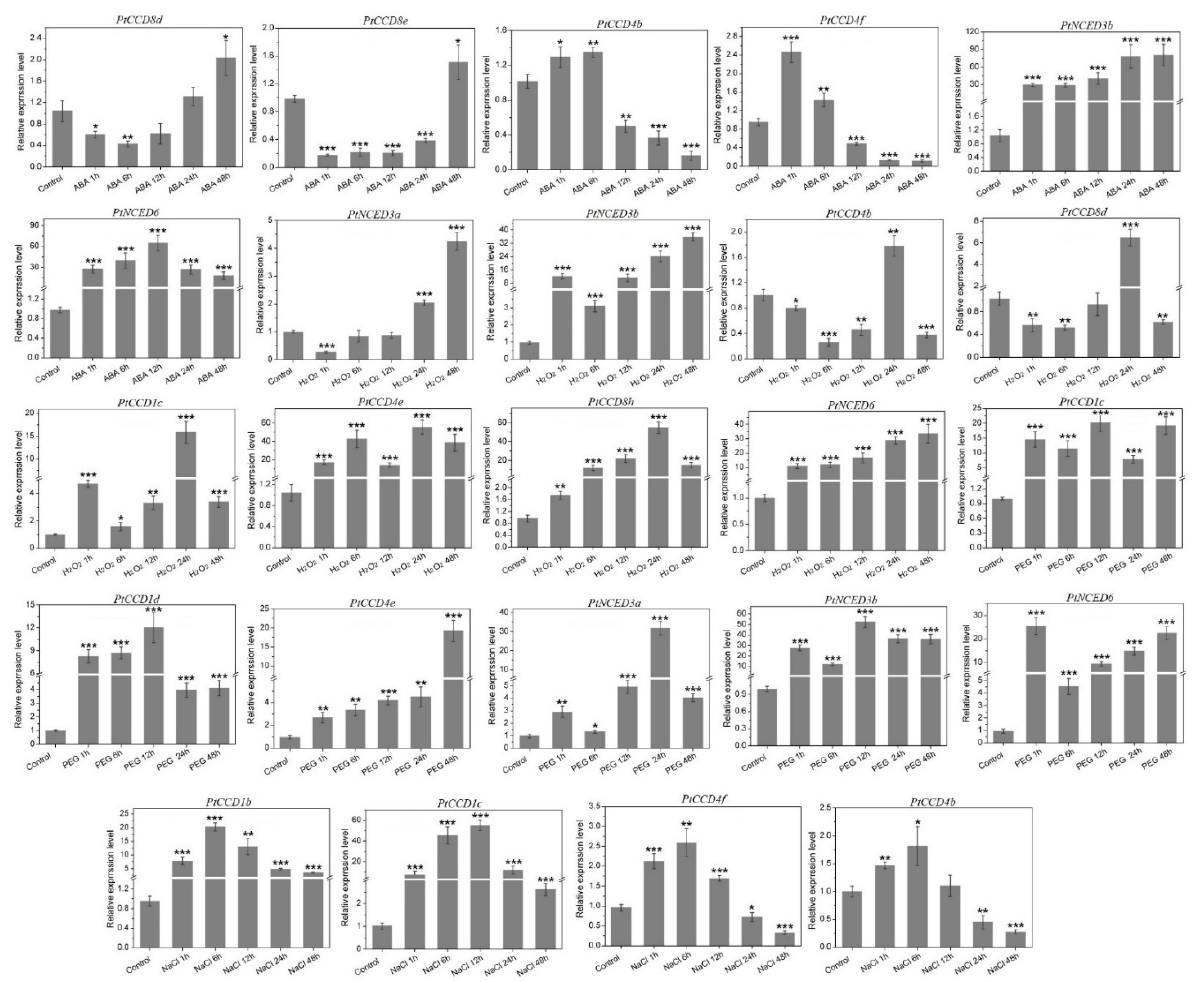
Figure 8. The qRT-PCR analysis of the PtCCD expression levels induced by abiotic treatments including ABA, H 2 O 2 , PEG 6000 , and NaCl. The vertical bars are representative of SD. Asterisk represents significant difference ( t -test, * p < 0.05, ** p < 0.01, and *** p < 0.001). Three independent experiments were performed. The data are normalized to poplar Ptactin (XM-006370951). PtCCD transcript levels were normalized to that in untreated leaves (control).